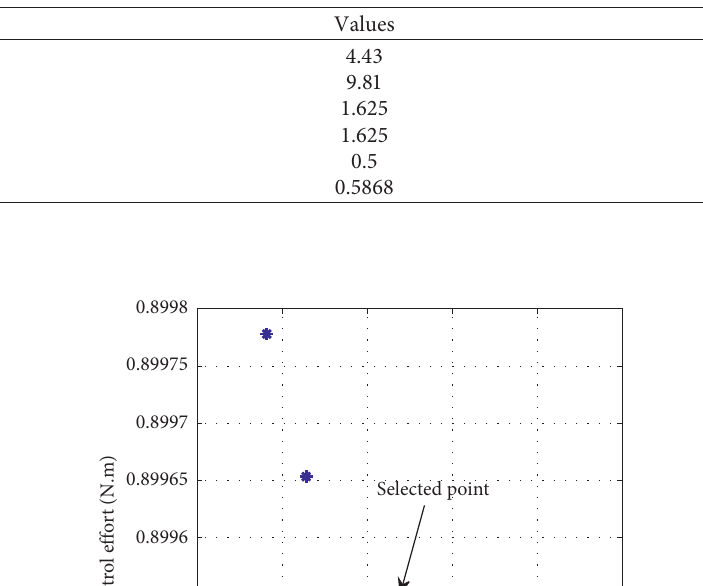
Table 1: Physical specifications of the flexible robot manipulator.